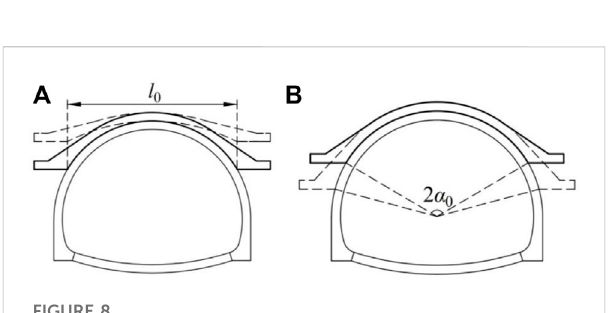
FIGURE 8 Calculation condition with different covered arch rises: (A) The span of covered arch is not changed; (B) The center of the covered arch is